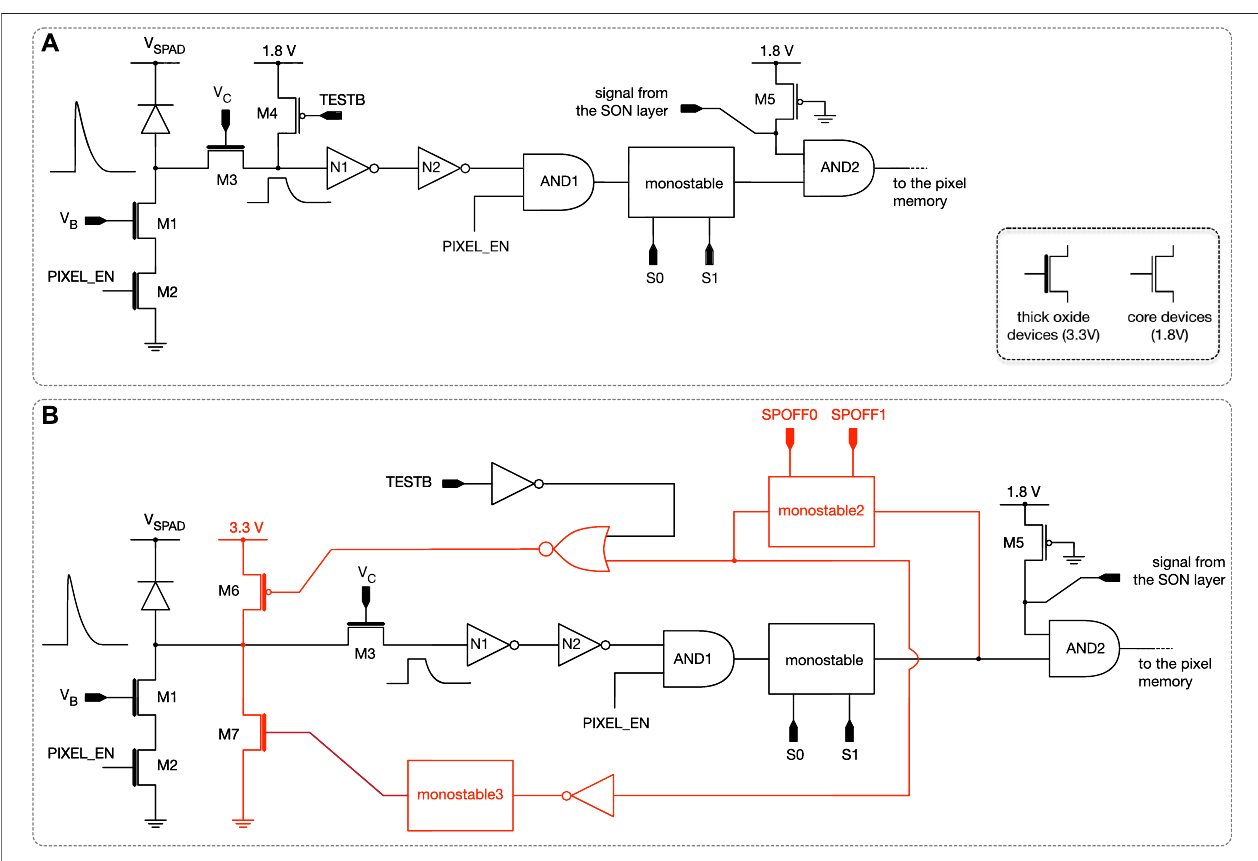
FIGURE 5 | Front-end circuits for SPADs in the FATHER chip: (A) with passive quenching network and (B) with active quenching network.